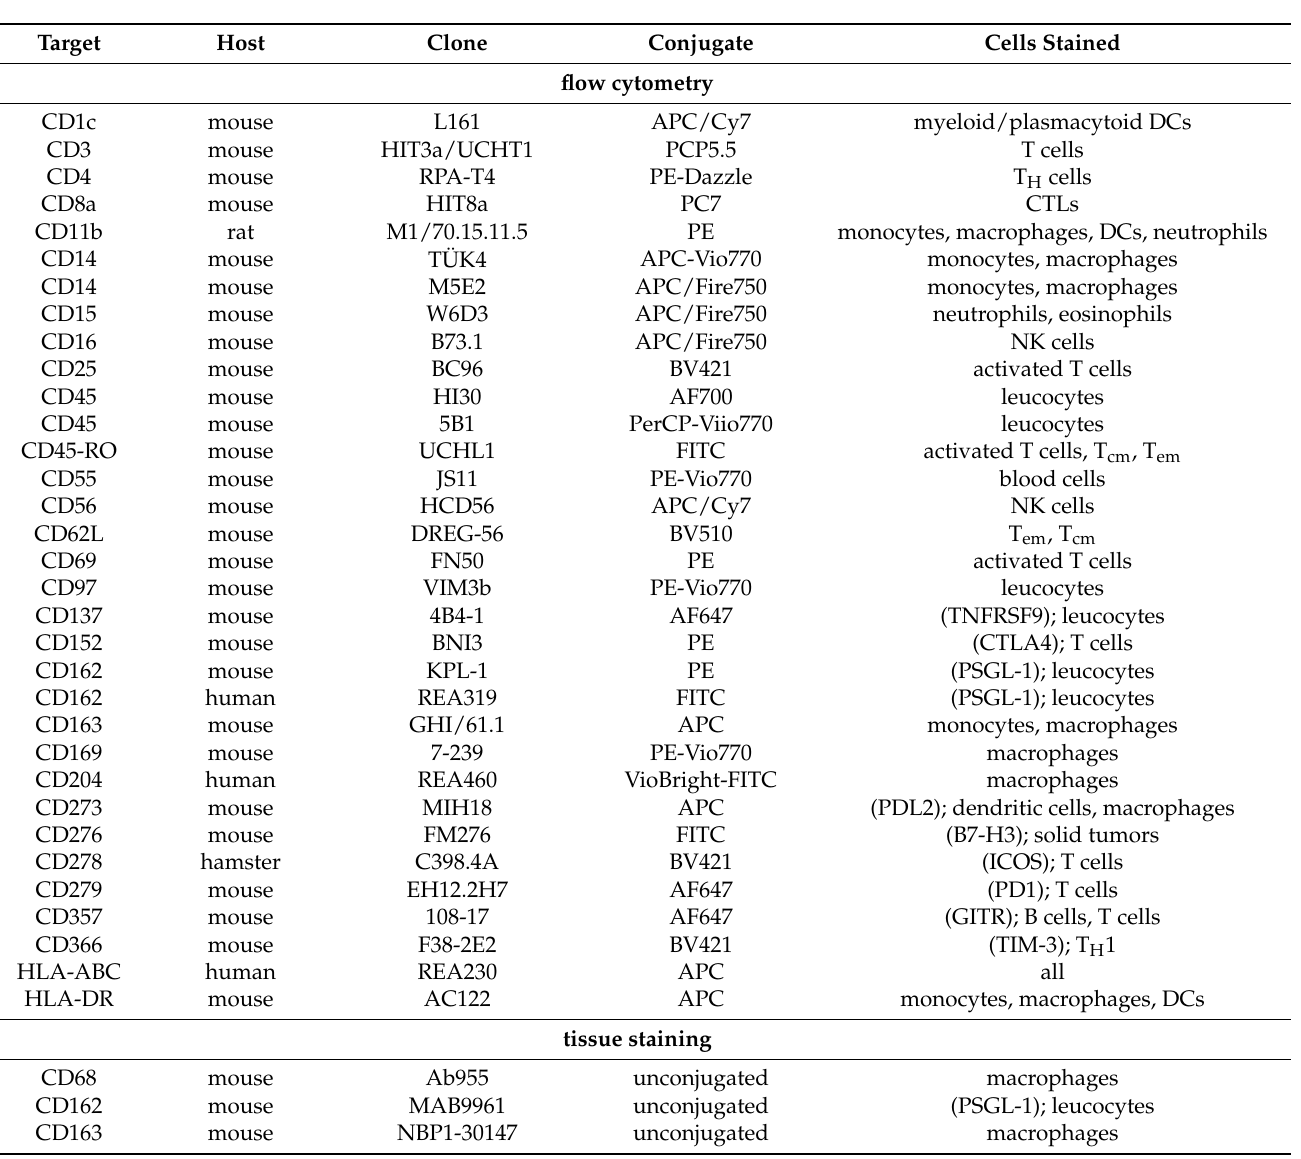
Table A2. List of antibodies used in this